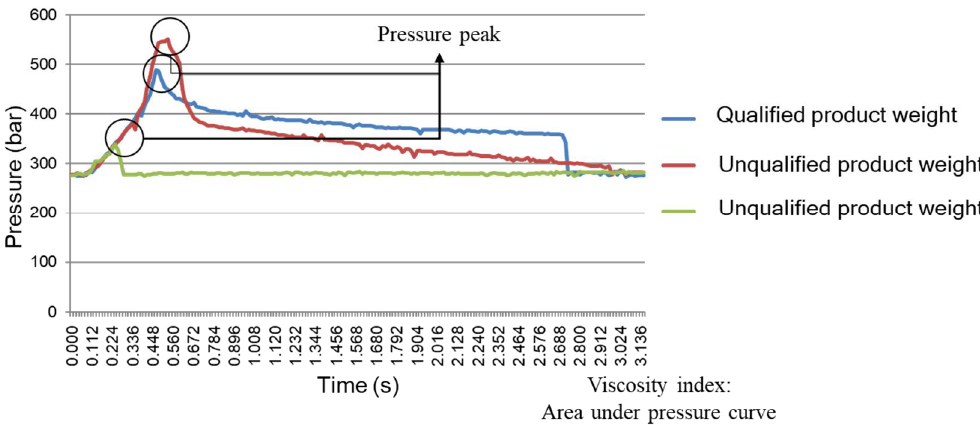
Figure 4. Product quality with different pressure curves.